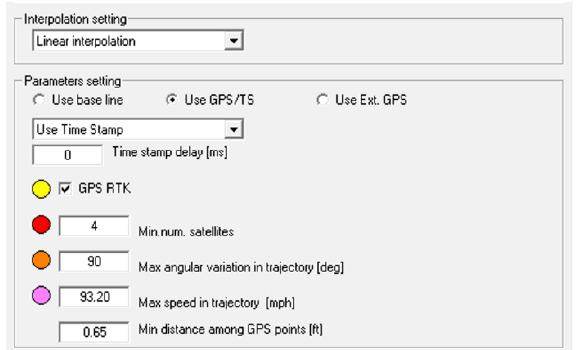
Figure 4. Applied parameters of filtration and interpolation of localising data in GRED HD software.